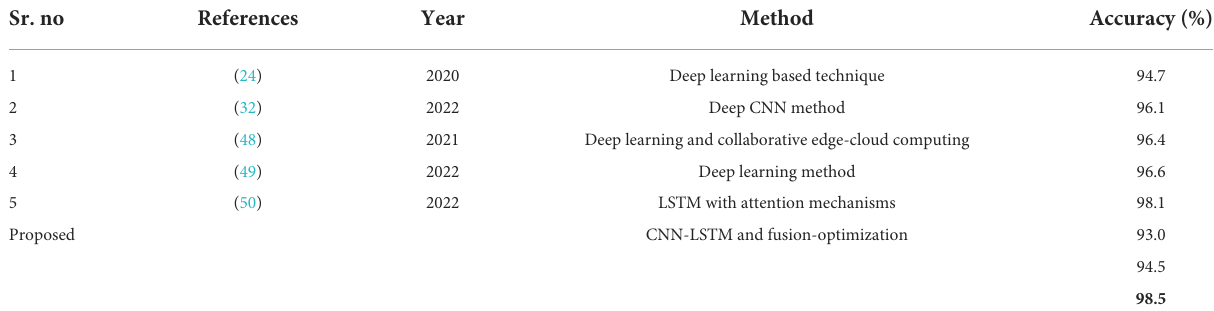
TABLE 8 Comparison of the proposed framework with recent